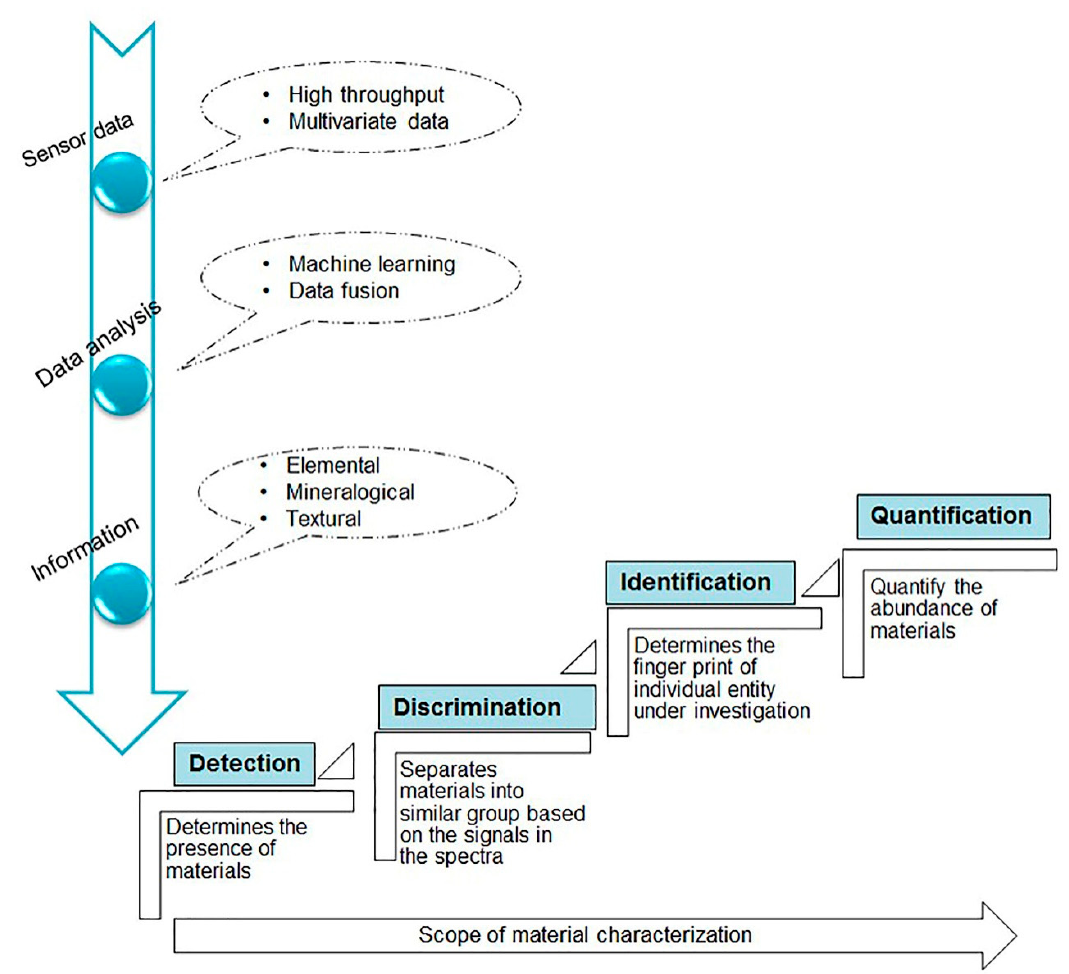
Figure 7. A schematic diagram illustrating the process of knowledge generation from sensor data and the depth of information.